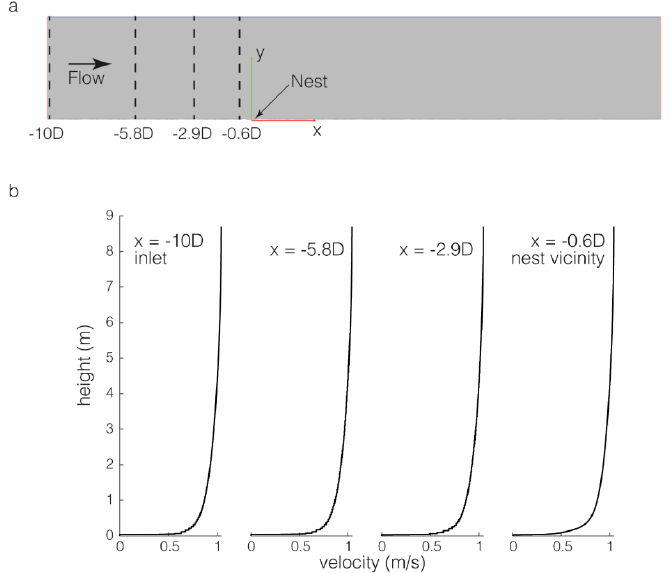
Figure 7. ( a ) Position of the line probes used to obtain the upstream vertical profiles; ( b ) Vertical profiles of mean streamwise velocity upstream of the nest for a ridge section. Furthermore, the outlet was extended to 30D and maximum velocity magnitudes of 84 points were compared with the corresponding points on the 20D domain to evaluate the change. The average change across the 84 points between two coarse mesh was 0.00251 (0.251%), whilst the difference between medium and fine meshes was 0.00243 (0.243%). The difference between the meshes is low, hence the flow is considered independent of the domain.